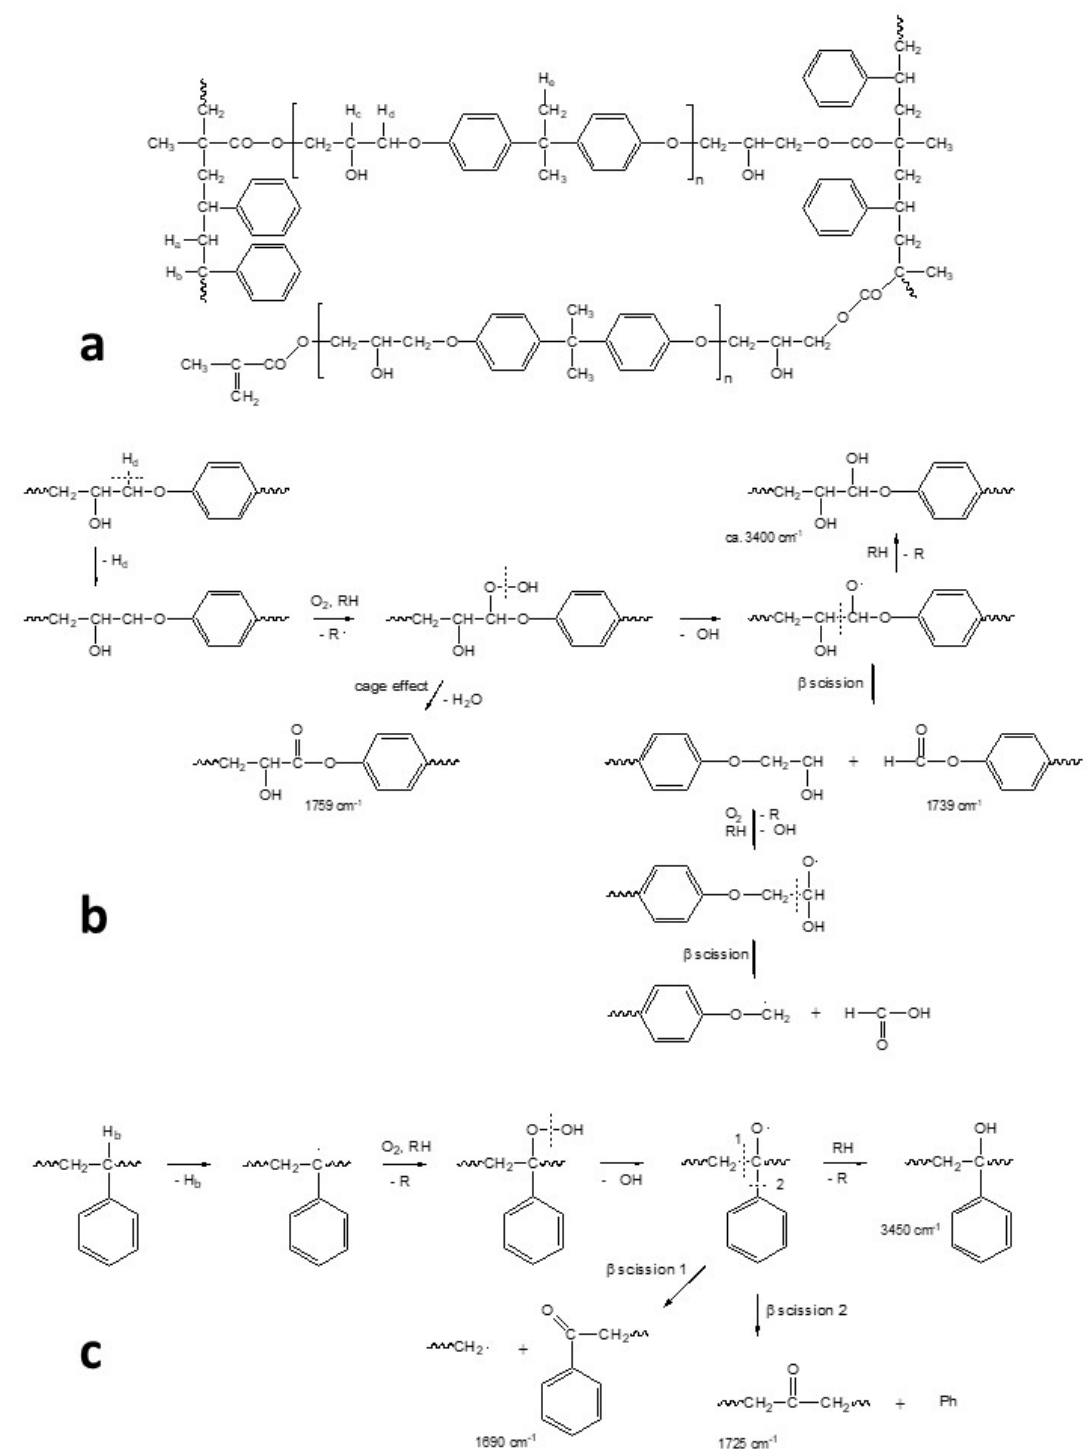
Figure 12. Schematic structure of the epoxy vinyl ester network showing the main different types of hydrogen atoms ( a ). Schemes of the main oxidation reactions taking place in the epoxy vinyl ester prepolymer residues ( b ) and in the styrene residues ( c ), as well as the absorption peaks in the infrared region of the main products. Image reprinted with permission from [27].